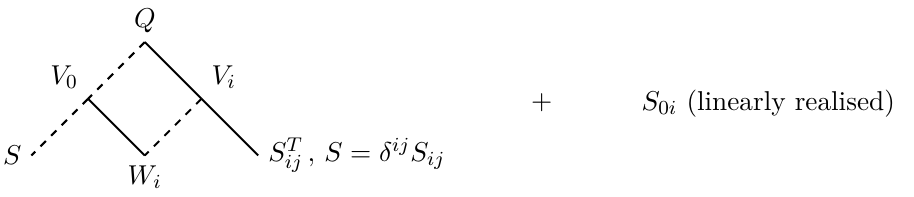
Figure 6. Inverse Higgs tree for the special galileon broken phase. This theory is not included in our classification because there is an additional linearly realised generator S 0 i